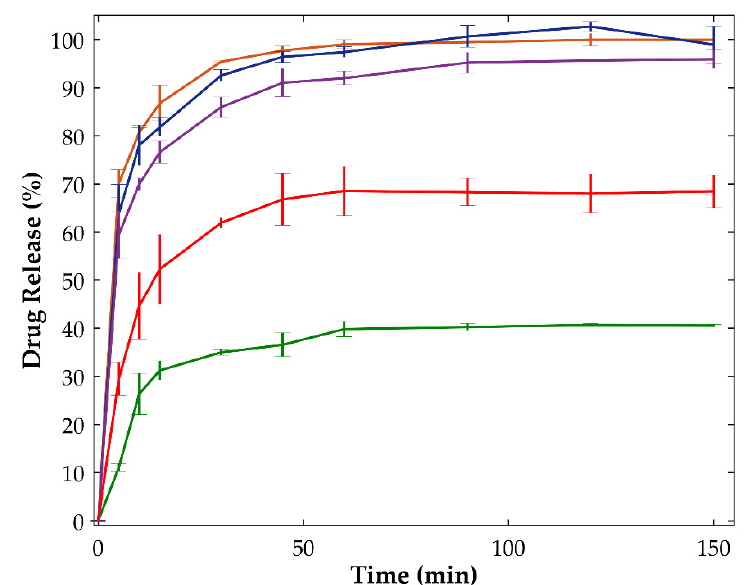
Figure 9. Dissolution profiles of samples containing the physical mixture of crystalline olanzapine (green), the physical mixture of quench cooled olanzapine (orange) and granules (25% of water) containing quench cooled olanzapine dried at 40 °C (blue), 65 °C (purple) and 90 °C (red) (n = 3, 100 rpm, non-sink conditions, 500 mL, 37 °C, phosphate buffer pH 8.0).